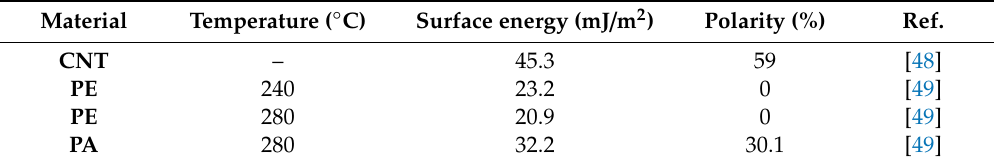
Table 2. Surface energy and polarities of the polymers and